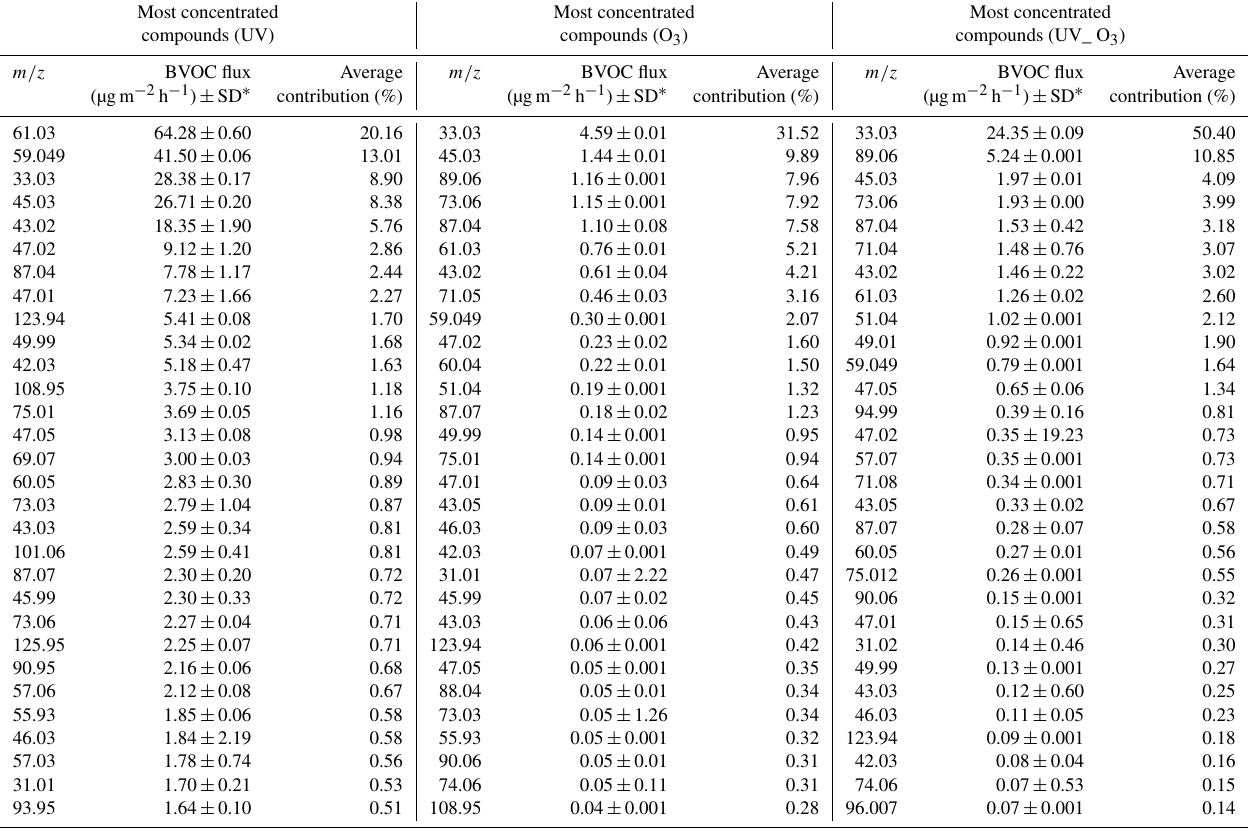
Table 2. The average of 30 most emitted compound during the 6d of measurement for the three different conditions: UV light irradiation, ozone, and UV light irradiation and ozone at the same time. The flux was calculated using the averaged surface of the leaf litter between the initial covered surface (0.64m 2 ) and the final covered surface (0.45m 2 ). Within the columns m/z , the compounds highlighted as the most differentiating between the VOC profiles by the PCA are in bold. A tentative identification of the compound here listed is reported in Supplement Table